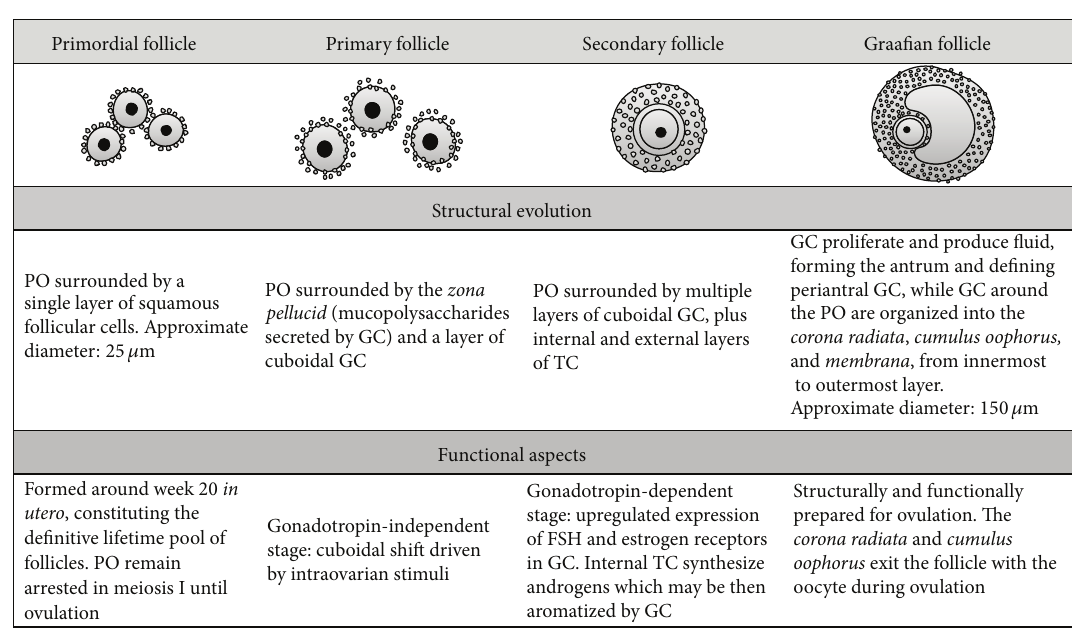
Figure 7: Follicular stages in